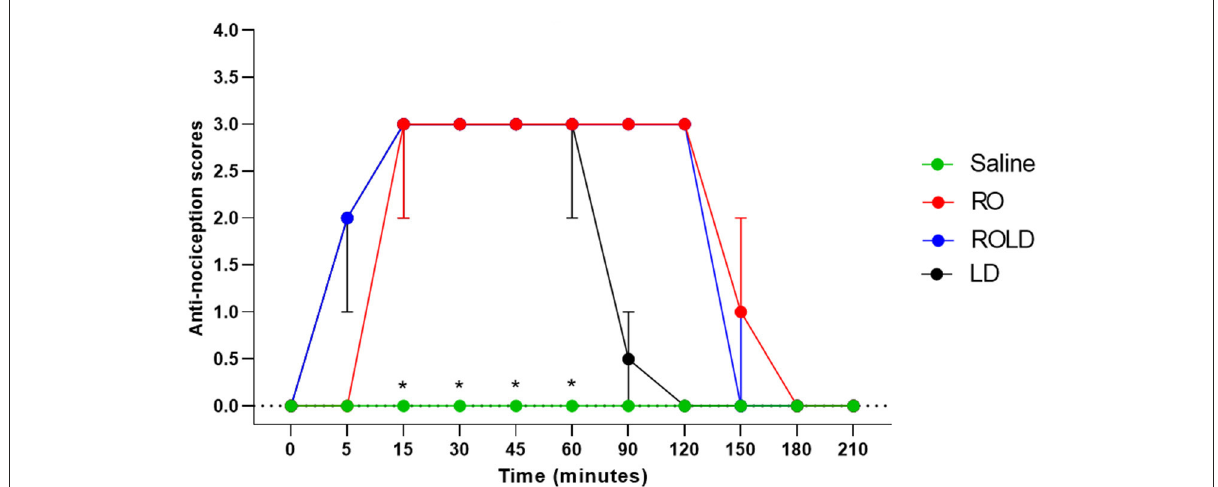
FIGURE1 Anti-nociception scores (median and range) in the tail, perineum, inguinal region, caudal aspect of the upper hind limbs, flank and chest regions (Response to “pin-prick” stimulation) pre- epidural and post- epidural administration of saline ( n = 6), romifidine (RO) (50 µ g kg − 1) ( n = 6), romifidine-lidocaine (ROLD) (50 µ g and 0.30mg kg − 1) ( n = 6) and lidocaine (LD) (0.3 0mg kg − 1) ( n = 6) in donkeys. *: Saline differ significantly from RO, LD, and ROLD combination.